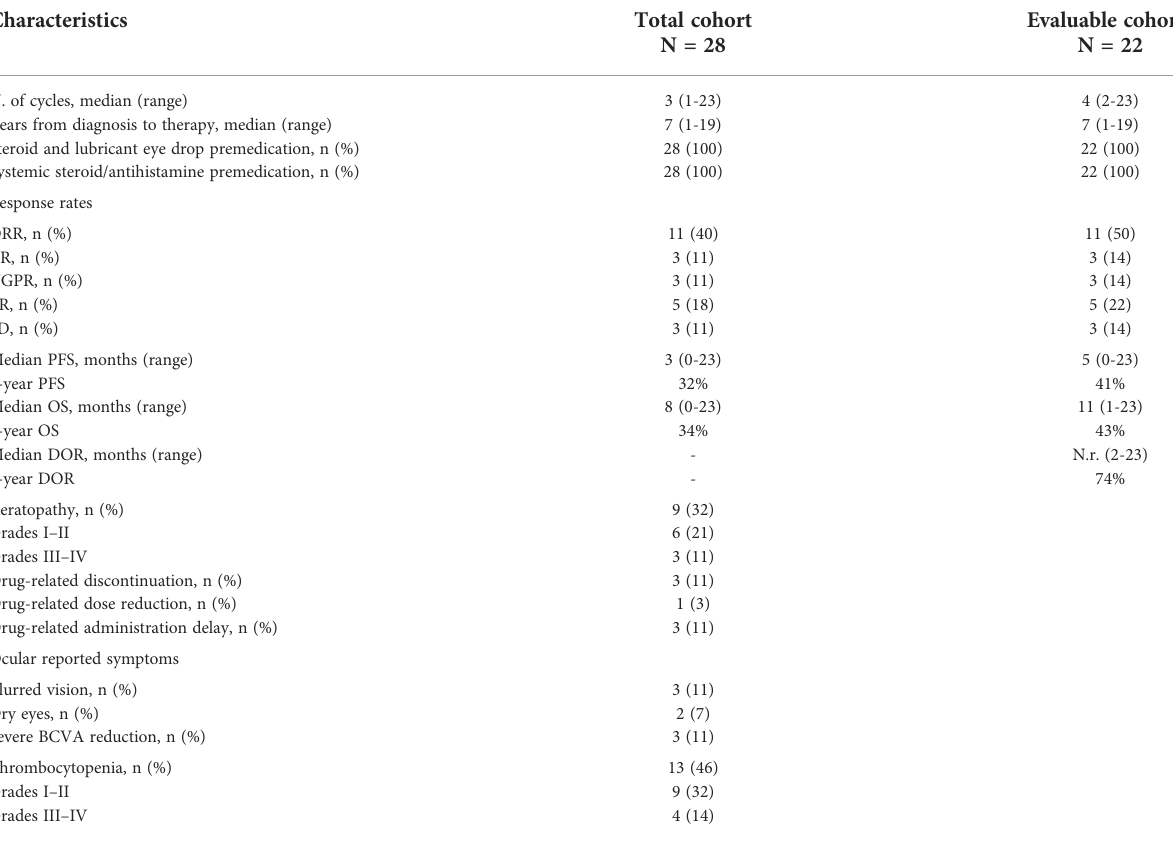
TABLE 2 Clinical outcomes and toxicities. Characteristics